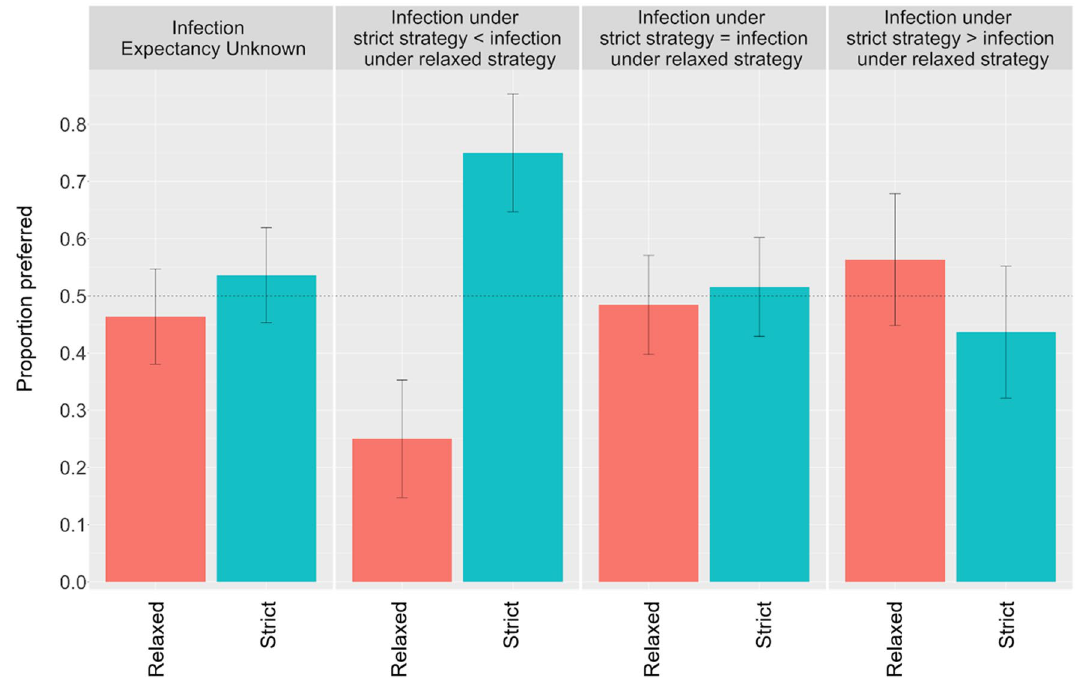
Figure 1. Study 1 results: Proportions of people who preferred each type of advice strategy under various infection expectancy conditions; dashed line: indifference rate (random choice between 2 options); error bars: 95% confidence